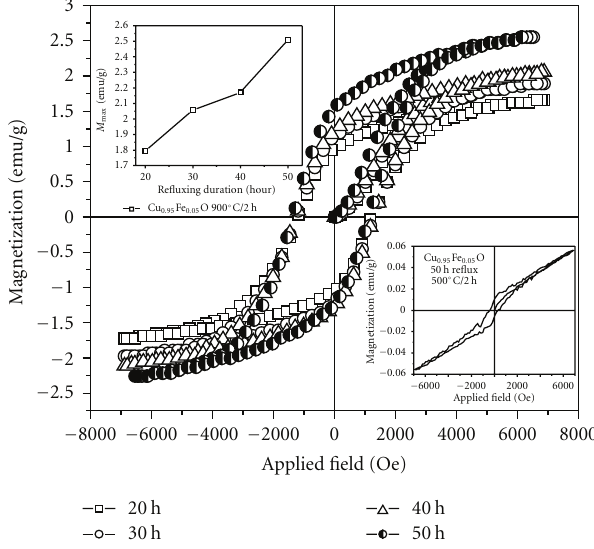
Figure 10: Hysteresis behavior of Cu 0 . 95 Fe 0 . 05 O refluxed for various durations and annealed at 900 ◦ C/2h. Bottom inset represents the paramagnetic behavior of 50 hour refluxed Cu 0 . 95 Fe 0 . 05 O annealed at 500 ◦ C/2h. Top inset represents the increase in M max value with increasing refluxing